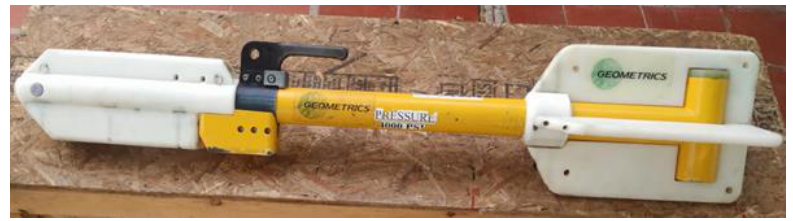
Figure 4. Geometrics G-882 marine magnetometer. Source Karem Oviedo Prada, 2020.